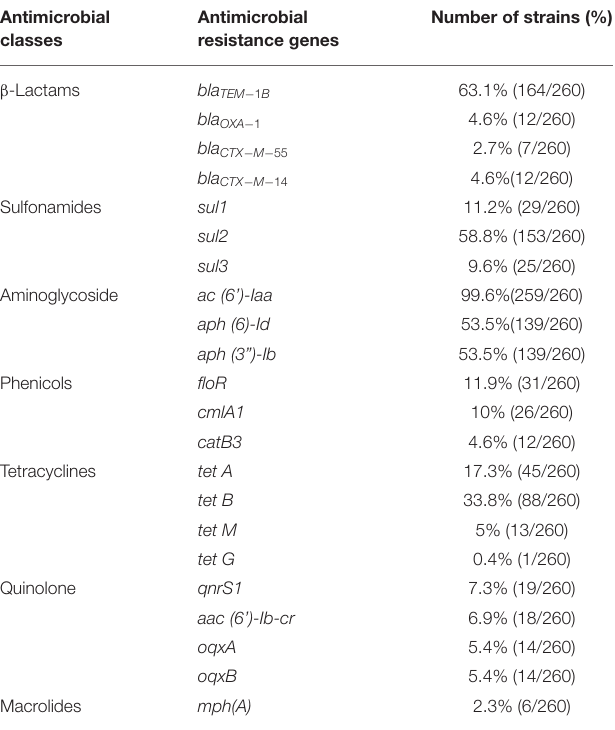
TABLE 3 | Major antimicrobial genes and composition distribution in Salmonella strains. Antimicrobial